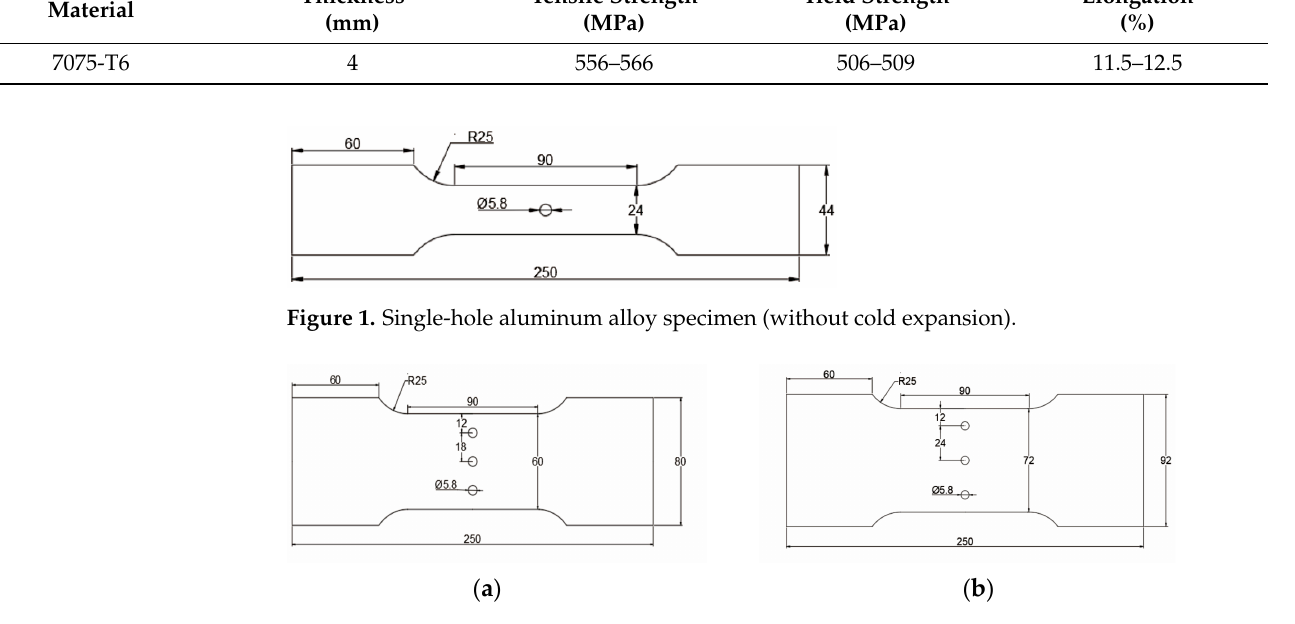
Figure 2. Three-hole aluminum alloy specimen (without cold expansion): ( a ) hole spacing is 3 times the final hole diameter, ( b ) hole spacing is 4 times the final hole diameter.